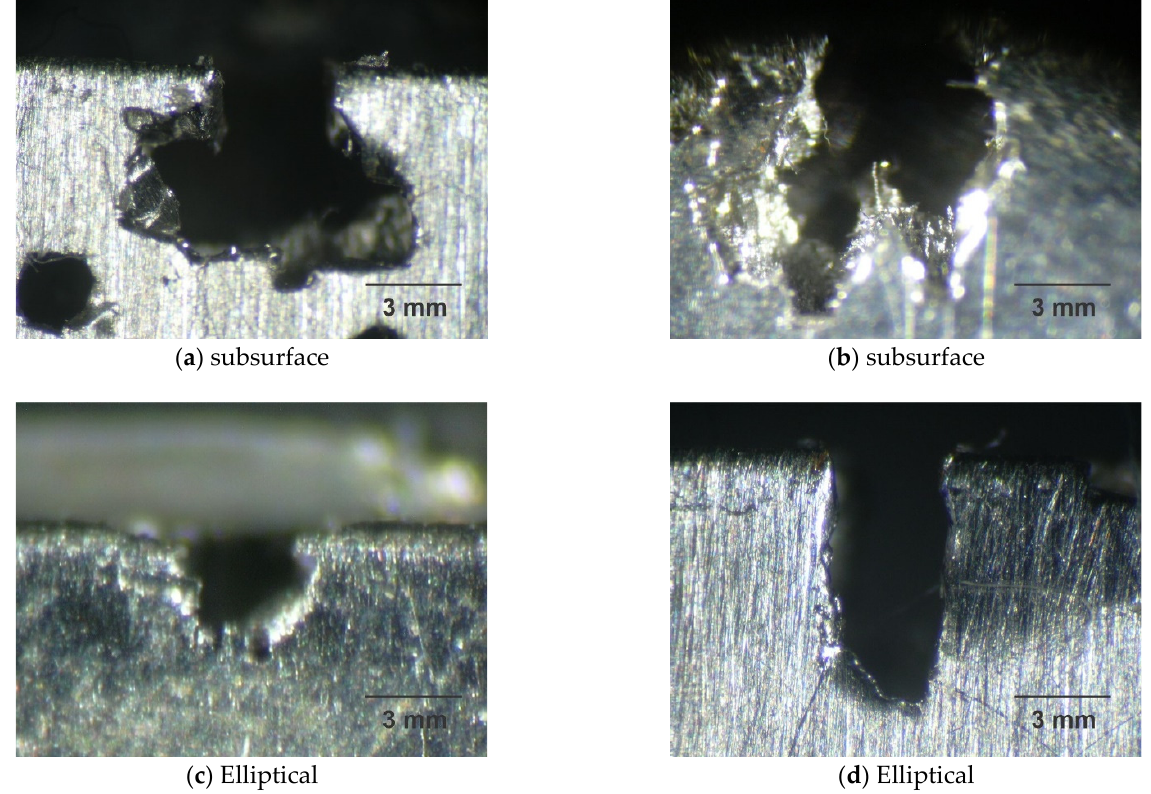
Figure 8. Shape of pit by micrographs obtained by optical microscopy for the samples A0 ( a ), A1 ( b ), B0 ( c ), and B1 ( d ), with magnification of ×25 after corrosion test.